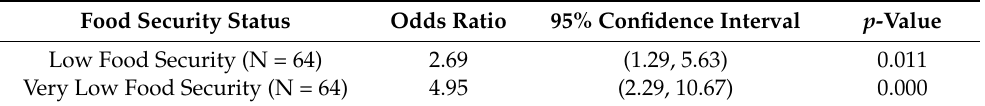
Figure 1. Mean USDA food security and CESD-R depression raw scores by food security status among 313 early care and education providers. Table 2. Primary model with logistic regression estimates (odds ratios) for the association between food insecurity and depression among a cohort of 313 early care and education (ECE) providers in Washington and Texas *.